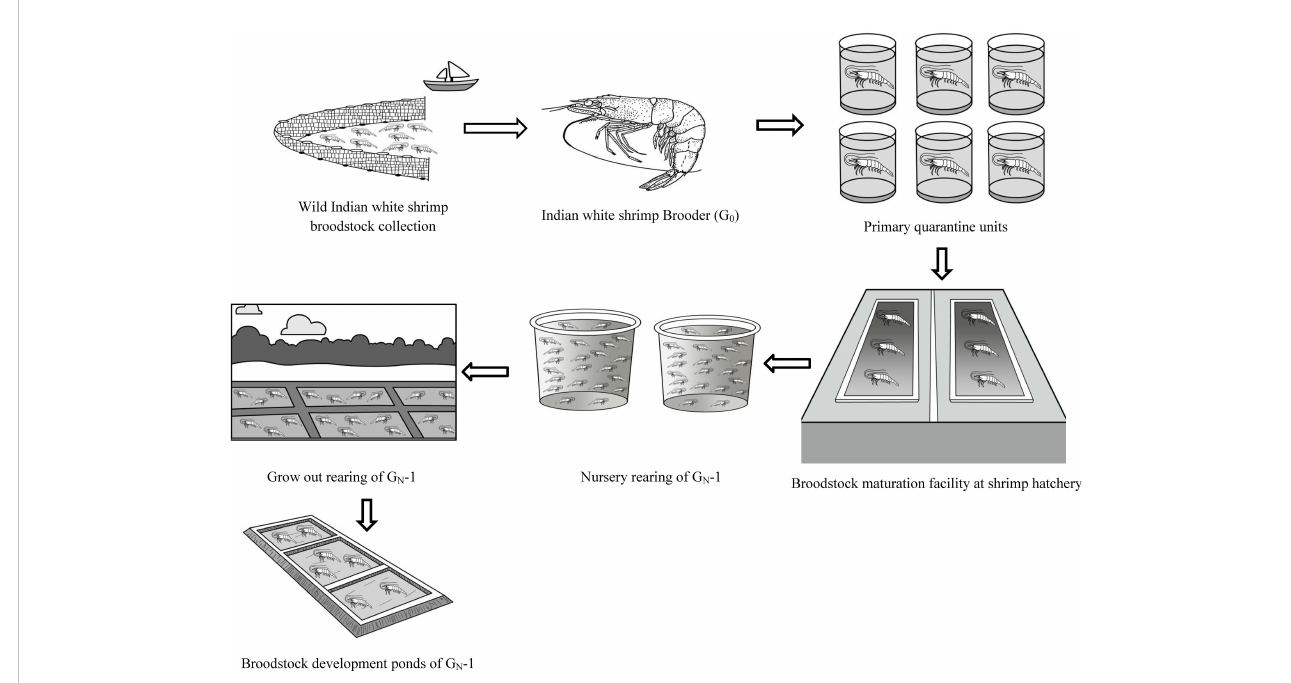
FIGURE 1 Schematic diagram of Trial I depicting the wild P. indicus broodstock (G 0 ) sourcing to initiate captive broodstock development program during 2018. The Post larvae (G N -1) raised from the G 0 stocks were nursery and grow out reared and subsequently raised in broodstock ponds. The matured broodstocks were spawned at the maturation facility at Muttukadu Experimental Station (MES) of ICAR-CIBA, Muttukadu, Tamil Nadu, India, and the life cycle was closed in captivity in 2019. The same procedure was followed for second-generation broodstock (G N -2) captive breeding in the year